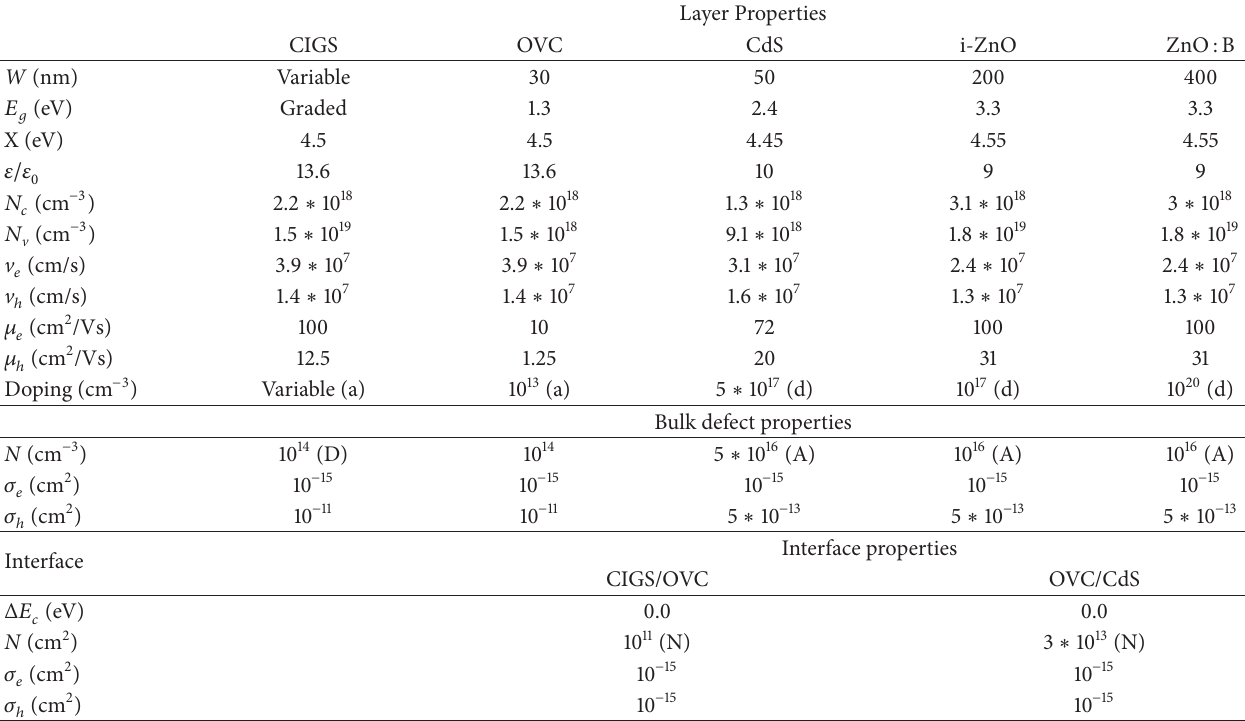
Table 1: Baseline parameters for modelling CIGS solar cells.